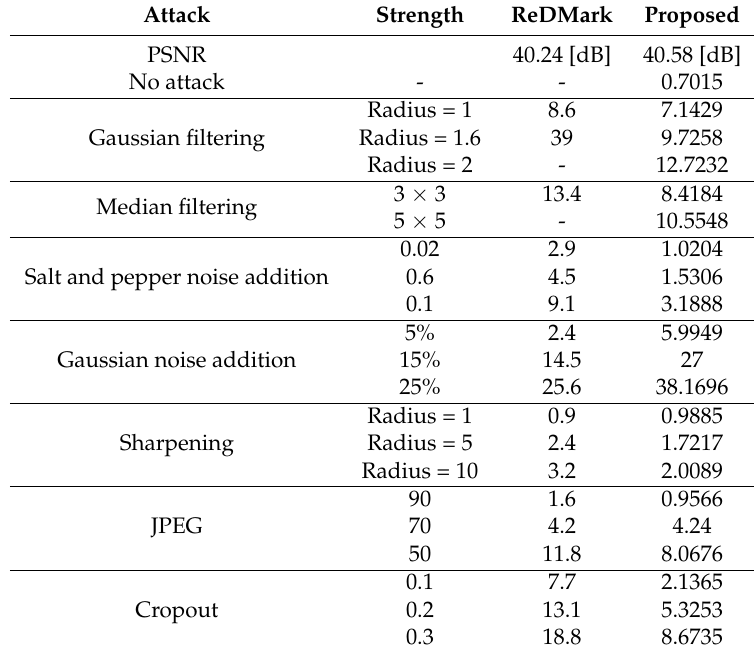
Table 6. Comparison of the proposed method with ReDMark [11].